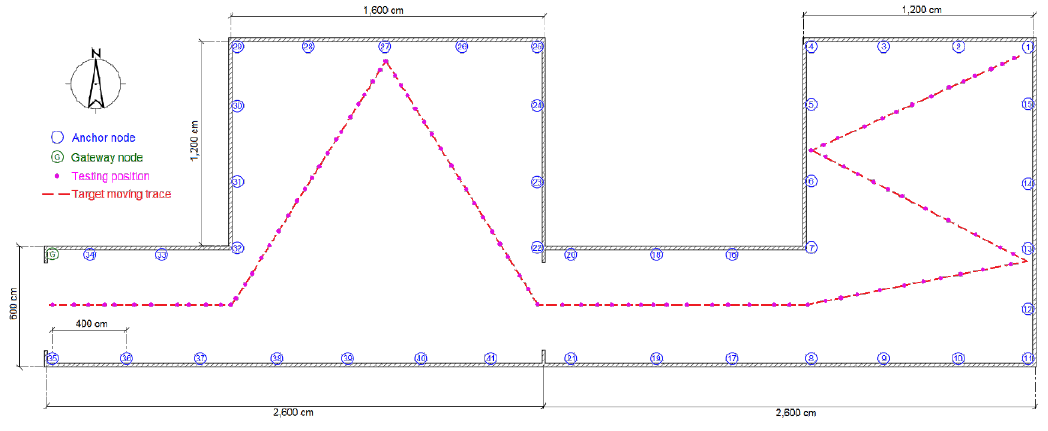
Figure 18. Map and nodes’ deployment for testing scenario 2.